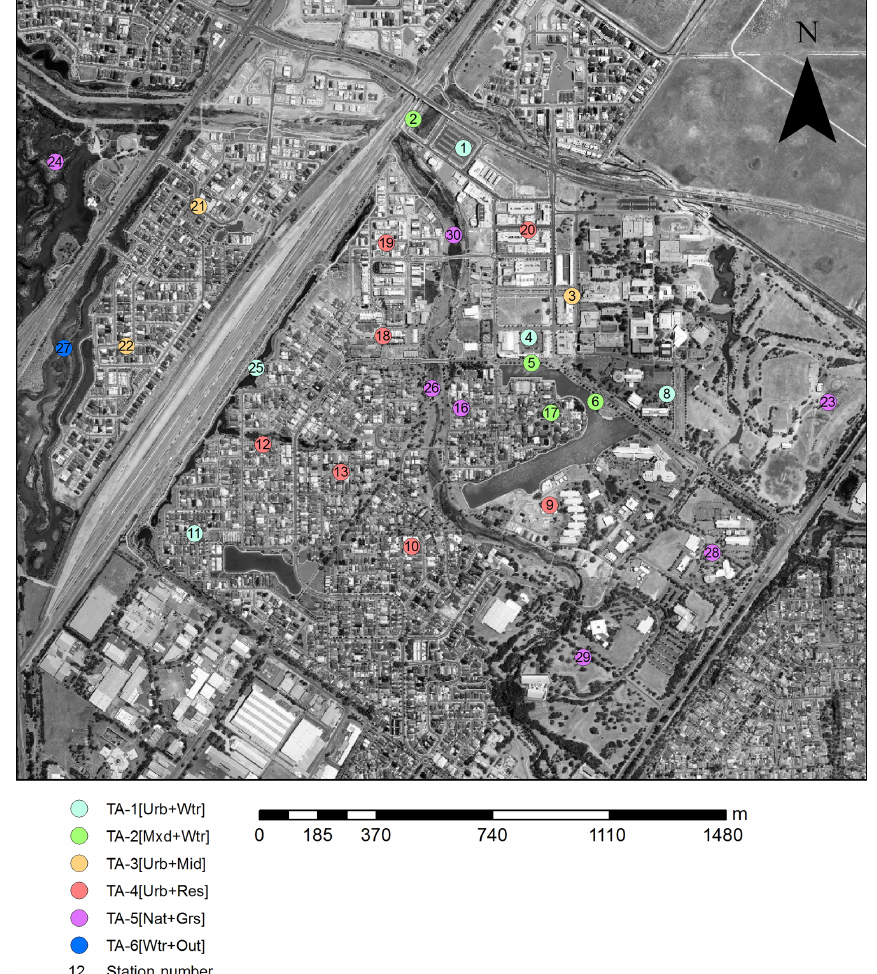
Figure 3. Mawson Lakes suburb with weather station locations. The numbers indicate individual weather stations, while the colour cod- ing specifies groups of sites with statistically similar thermal characteristics. The names of each cluster indicate the average land sur- face characteristics: urban sites with nearby water (TA-1 [ Urb + Wtr ] ), mixed land use with nearby water (TA-2 [ Mxd + Wtr ] ), urban mid-rise- type sites (TA-3 [ Urb + Mid ] ), urban residential sites (TA-4 [ Urb + Res ] ), natural grass-dominated sites (TA-5 [ Nat + Grs ] ), and a single outlier site (TA-6 [ outlier ] ) (Broadbent et al.,